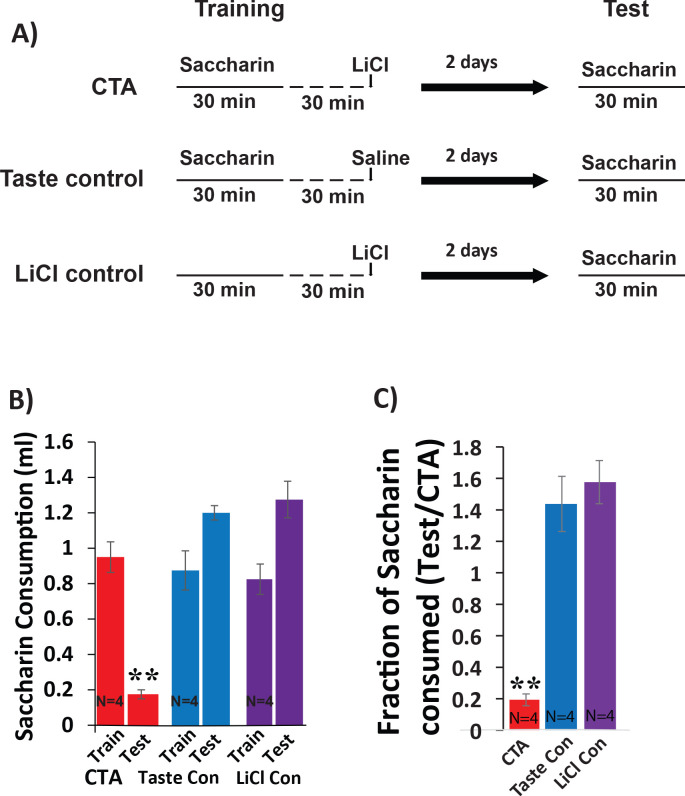
Testing CTA in mice.(A) Timeline showing behavioral paradigm. CTA and Taste control receive 30 min of 0.5% saccharin consumption followed by intraperitoneal injection (I.P) injection of lithium-chloride (LiCl; 0.15 M, 2% body-weigh) or saline 30 min later. The lithium control group receives the same I.P injection of LiCl, but no saccharin during the training phase. All groups were tested for consumption of saccharin during 30 min exposure 48 hr later. (B) Saccharin consumption decreases following LiCl-induced malaise (N = 4/group). There was a main effect (two-way mixed ANOVA) on the volume of saccharin consumed between groups across sessions: (F(2,9) = 18.09, p=7.03×10−4). Post-hoc analysis (Bonferroni corrected) between training and test within each group revealed significant differences only for the CTA group (CTA: p=5×10−3; LiCl control: p=0.14; taste control: p=0.051). (C) The strength of CTA memory was determined by quantifying the fraction of saccharin consumed on the test day relative to the training day. Comparing CTA strengths across groups revealed a significant difference f(2,9)=34.08, p=6×10−5 with significant pairwise differences for CTA vs taste control (p=2.5×10−4) and for CTA vs LiCl control (p=1.1×10−4), but not for the two control groups (p=1 for taste control vs LiCl control). *p<0.05; **p<0.01.